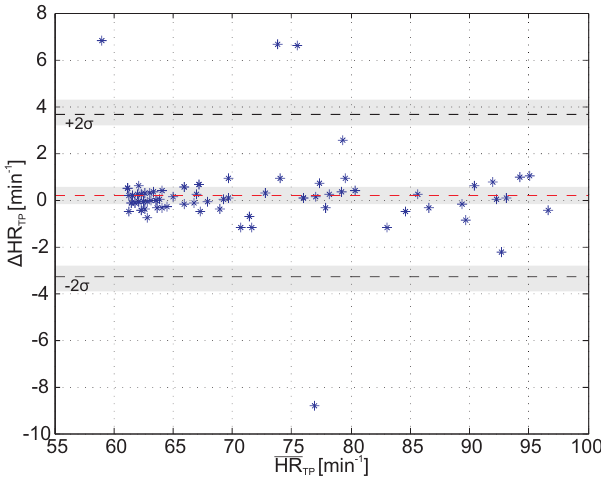
Fig.8: Bland-Altman plot of the new measurement device and the PPG as gold standard of the stretched leg.